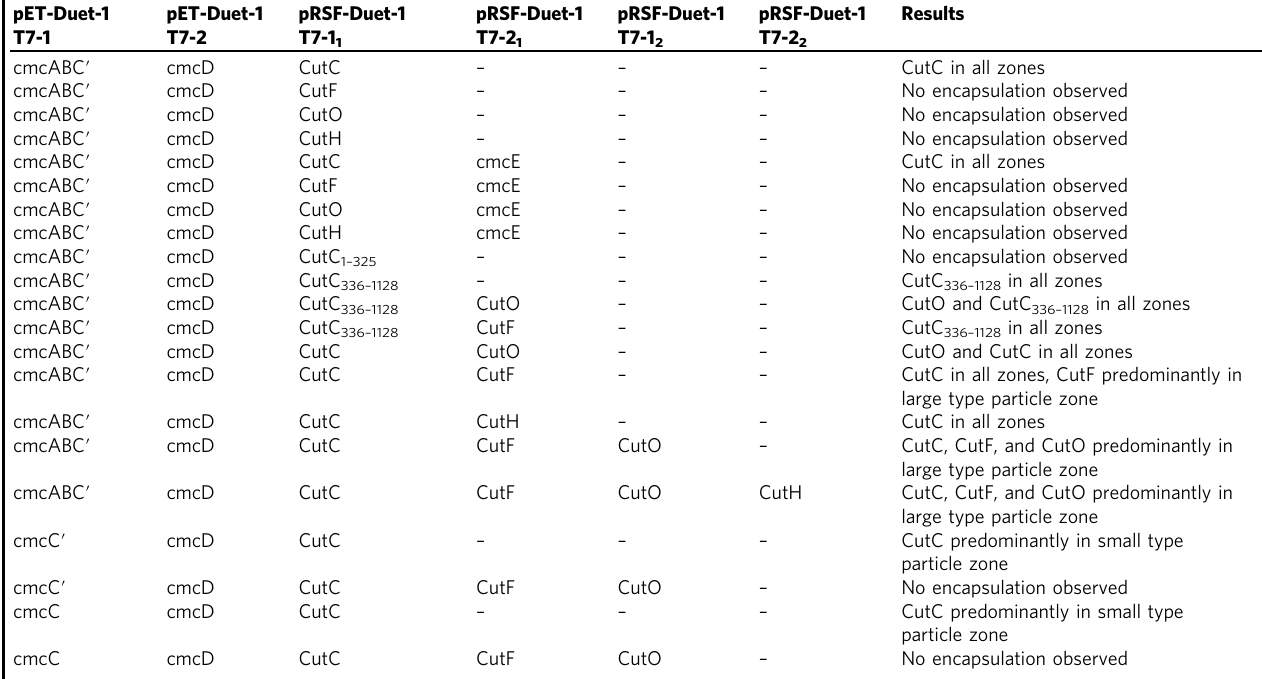
Table 2 Summary of BDP encapsulation experiments (Supplementary Figs. 13 –